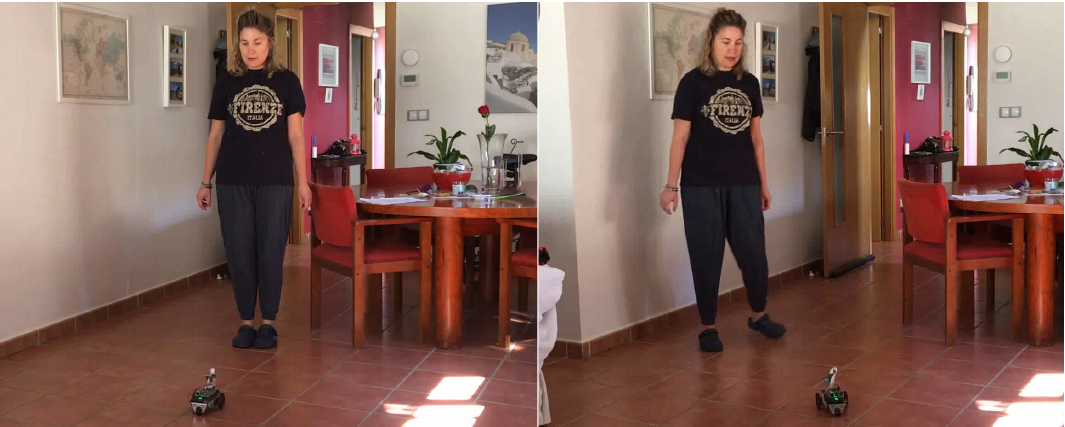
Figure 18. Navigation following a